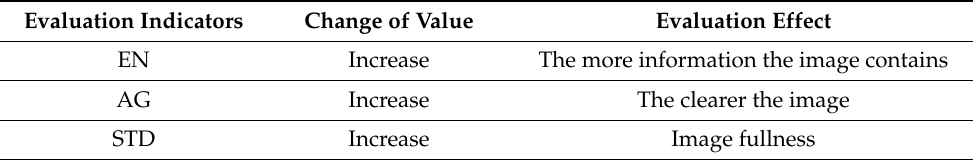
Table 1. Evaluation